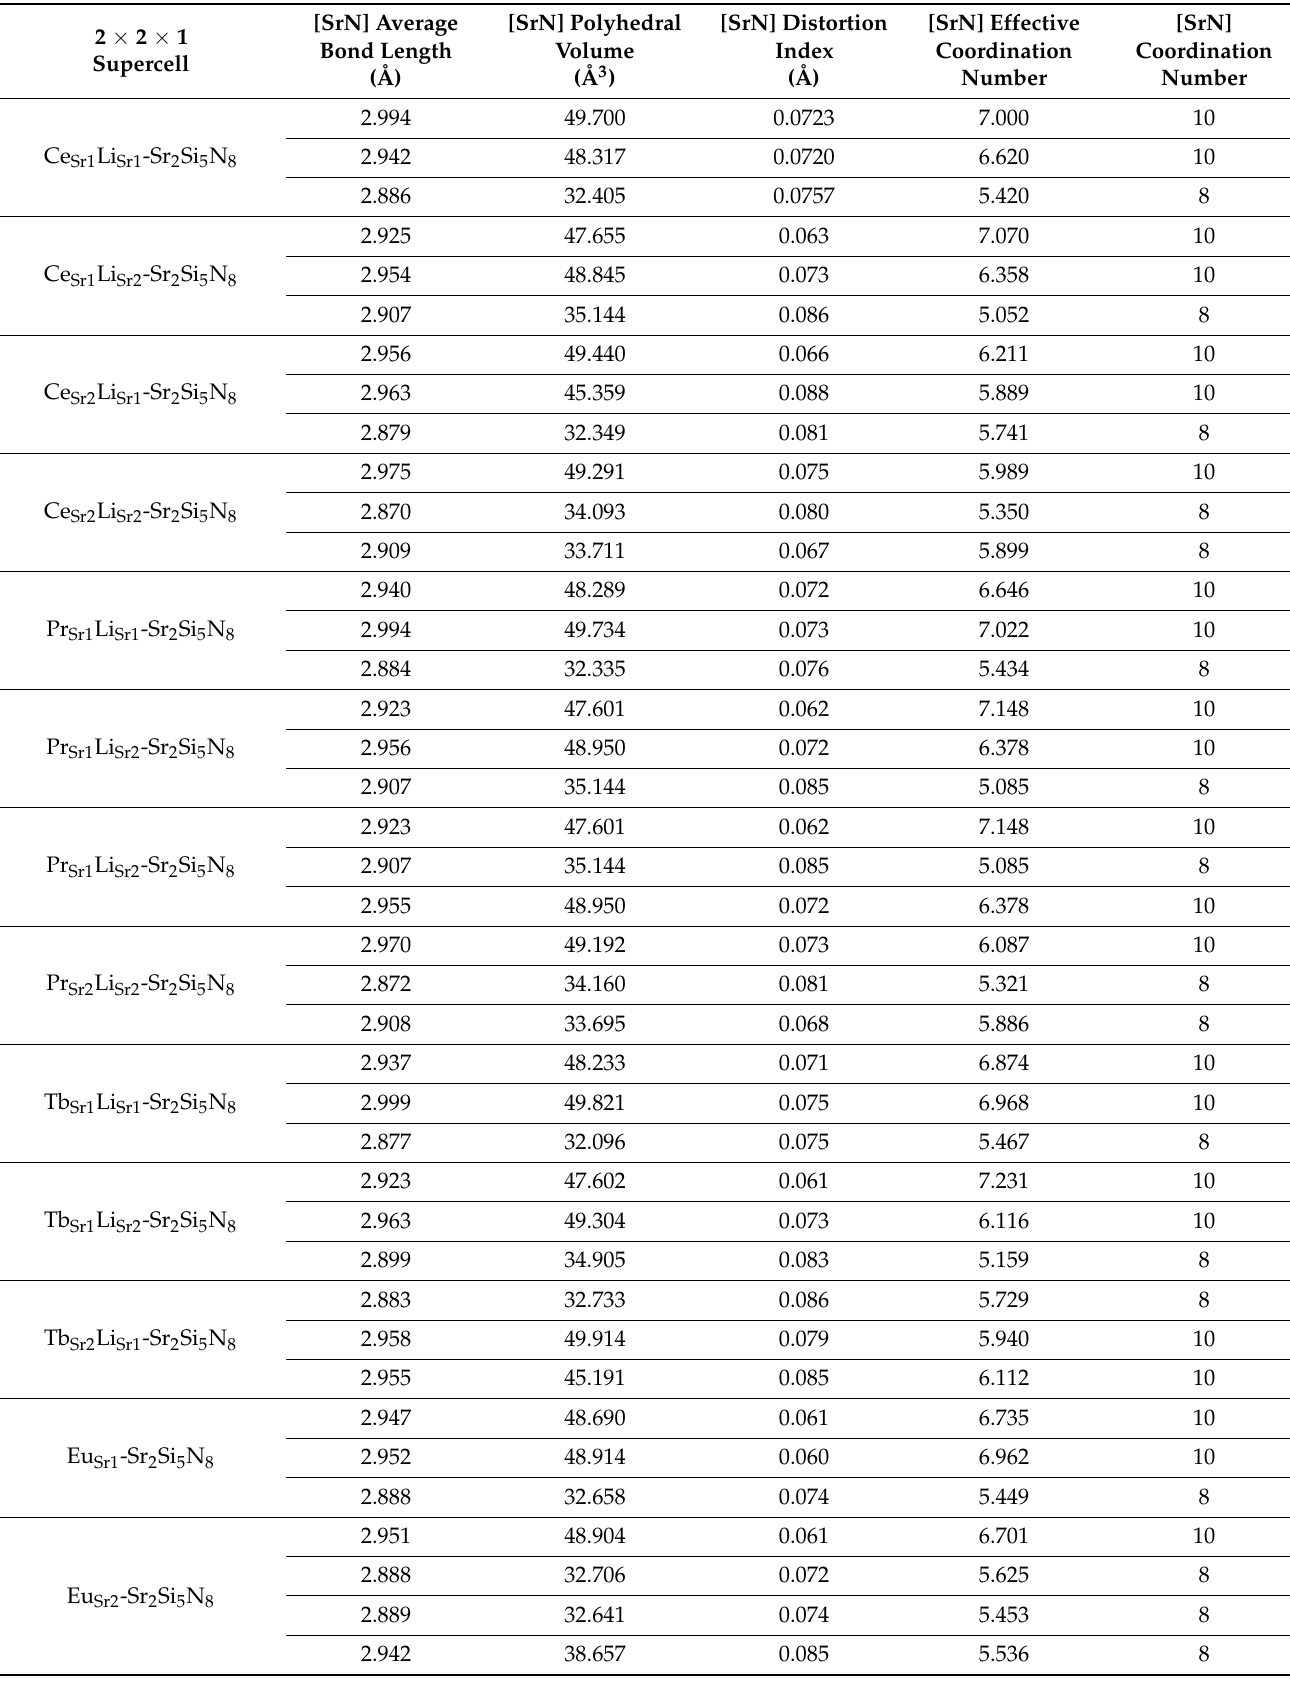
Table 2. [SrN] Coordination polyhedron parameters of Sr 2 Si 5 N 8 doped by Ln (Ce 3+ , Pr 3+ , Tb 3+ )/Li +